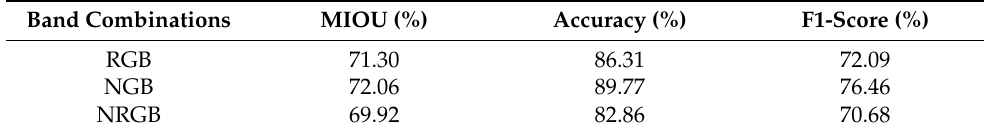
Table 4. 10-categories segmentation results of band combinations in Sentinel-2 images